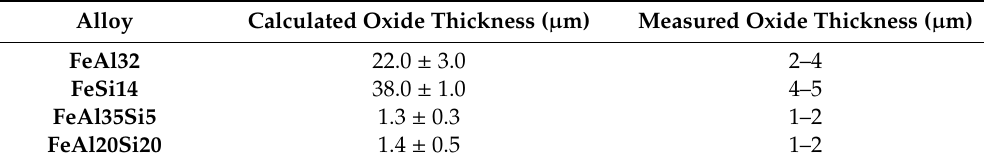
Table 6. Oxide layer thickness calculated from weight gains after 300 h of oxidation and measured on SEM